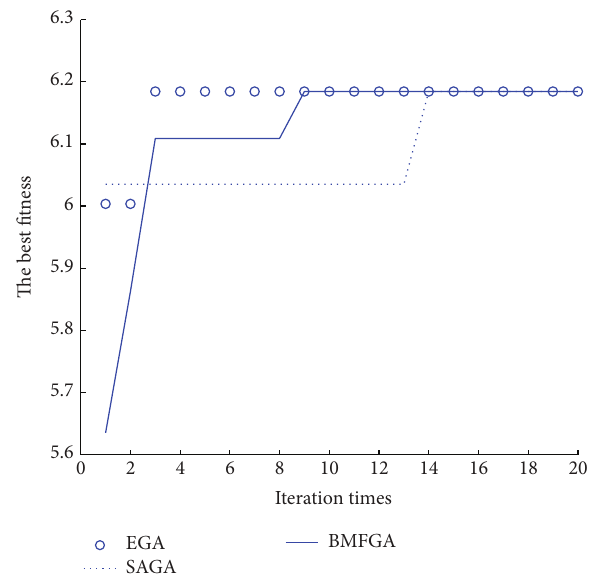
Figure 10: Convergence curves about the optimal